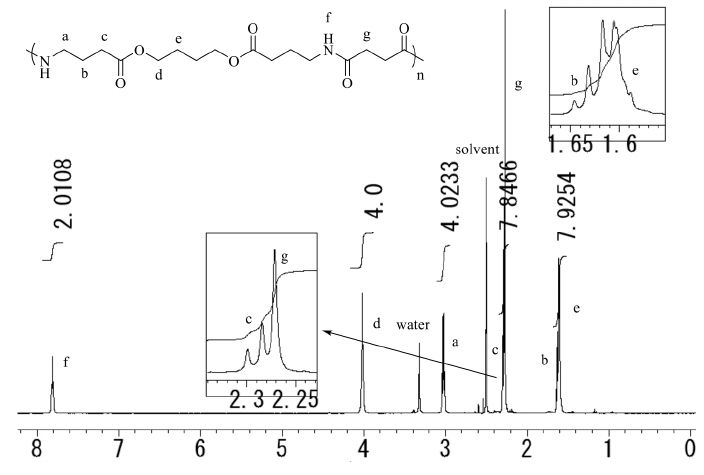
Figure 1. 1 H NMR spectrum of poly(gBgS) (DMSO- d 6 , 500 MHz, R.T.).